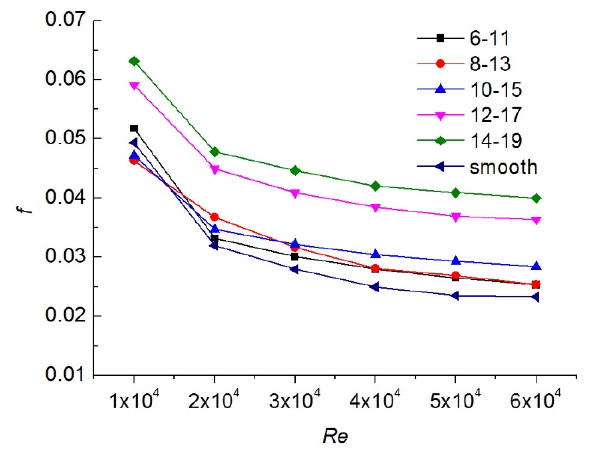
Figure 9. The variation of resistance coefficient f in shell with Re.